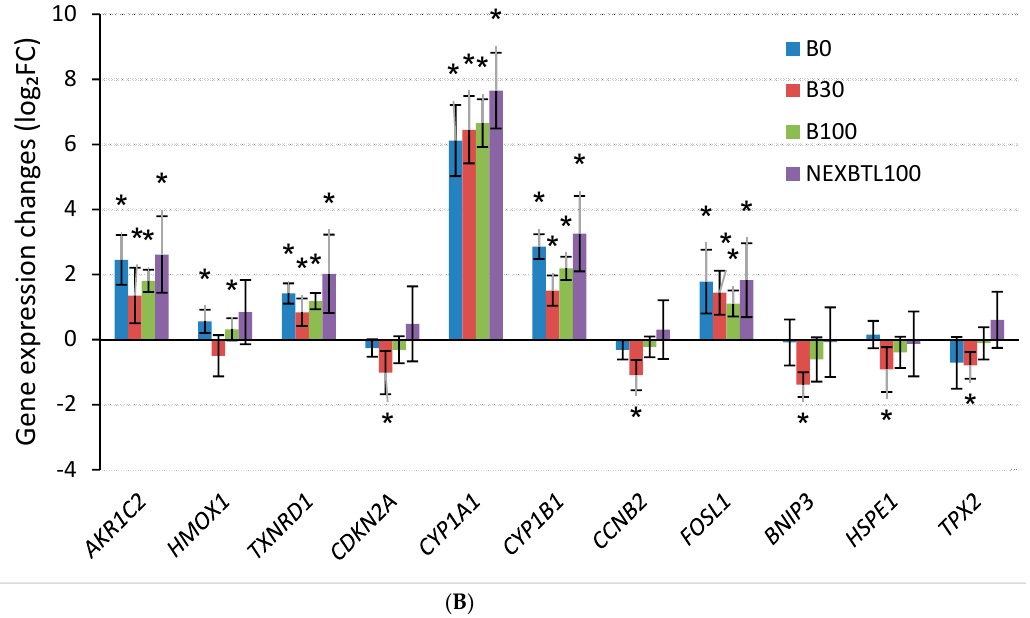
Figure 6. Quantitative RT-PCR verification of gene expression data obtained by microarray analysis. Eleven significantly deregulated genes were selected across all results and their gene expression levels were determined using qRT-PCR. Gene expression changes (log 2 FC) were obtained by normalization to control samples (2 −ΔΔ C T method). Expression changes of selected genes upon: ( A ) 4 h exposure; and ( B ) 24 h exposure. * Indicates a statistically significant difference ( p -value < 0.05).